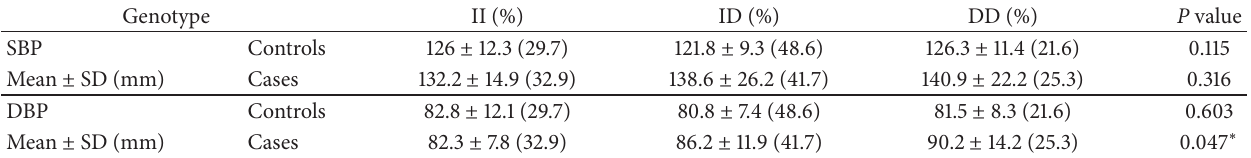
Table 2: Association of systolic and diastolic blood pressure with ACE I/D